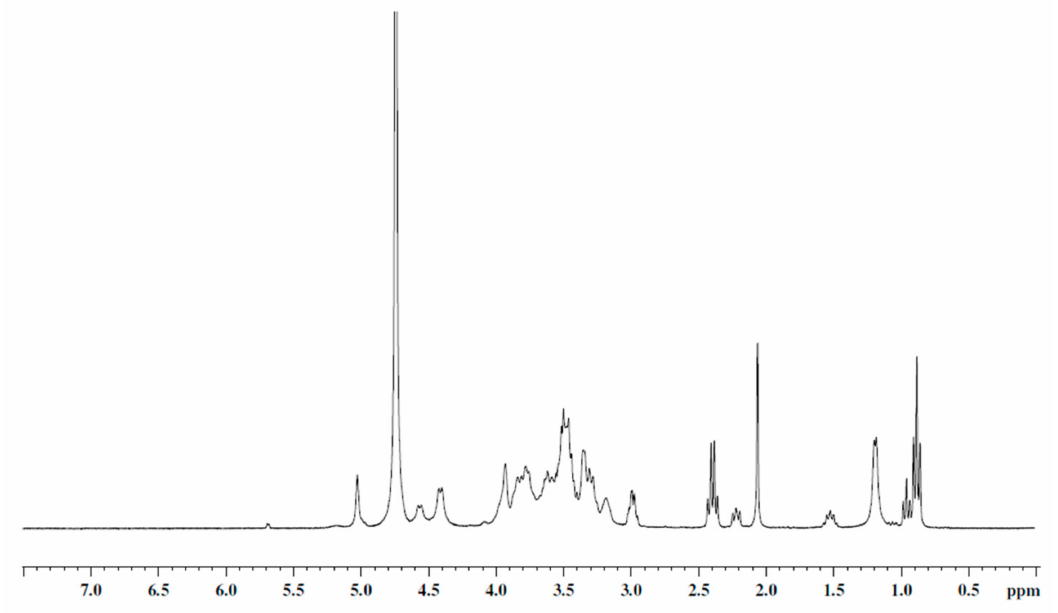
Figure 1. 1 H NMR spectrum of GG-LA derivative, D 2 O / NaOD, 300